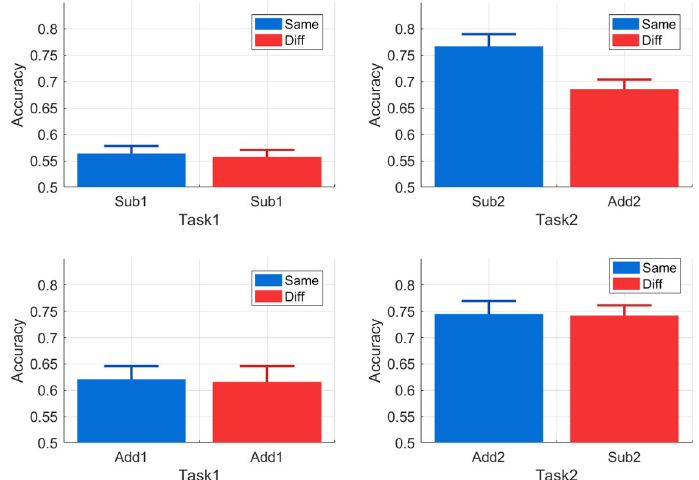
Fig 5. Increases in Task 2 Accuracy for Same versus Different Subspace. The barplots show the mean accuracies for Tasks 1 and 2 as a function of whether the second Task is in the same subspace as the first. These results are shown separately for Task 1 = Sub1 (top row) and Task 1 = Add1 (bottom row). For Task 1 = Sub1 there is a significant increase in Task 2 accuracy (of 8.2%) for same versus different subspace (top right). For Task 1 = Add1, mean Task 2 performances are not significantly affected by subspace (bottom right). The error bars indicate the standard error of the mean.